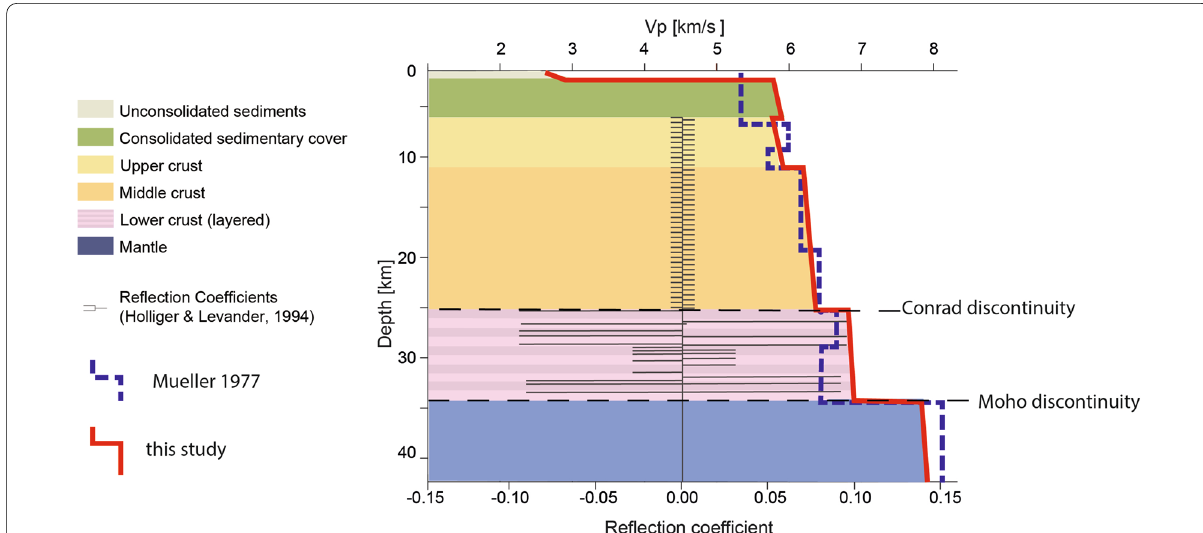
Fig. 14 Schematic model of continental crust based on Müller (1977). The depth of interfaces are based on the interpretation of the ALP 87 seismic refraction profile J-ED (Maurer & Ansorge, 1992). Averages velocities have been corrected for lithostatic pressure and temperature (see text) using a geothermal gradient as proposed by Okaya et al. (1996) below the Calcareous Alps. Reflection coefficients as calculated by Holliger and Levander (1994) are also